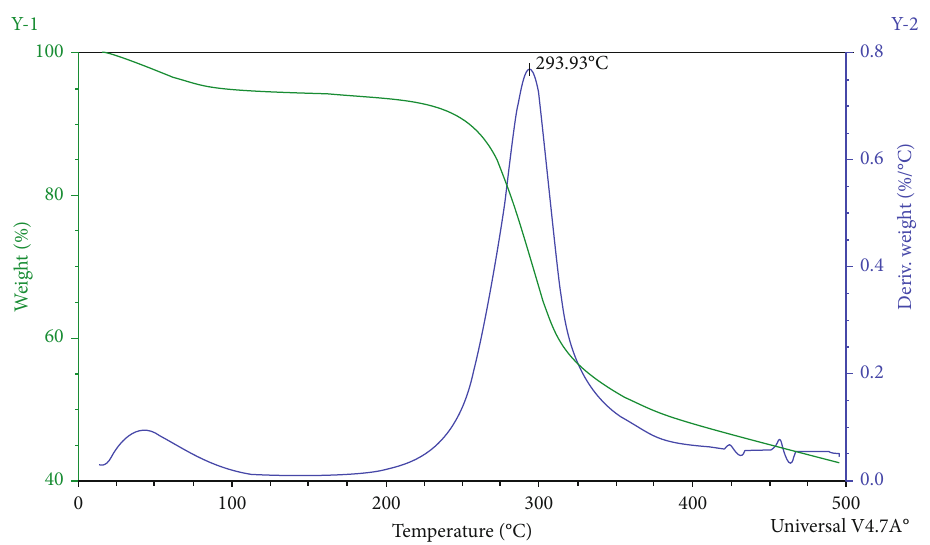
Figure 6: TGA Ag [A]-Qs QDs. The decomposition temperature of the compound (293.93 ° C) at a heating rate of 10 ° C/min in gas nitrogen fl